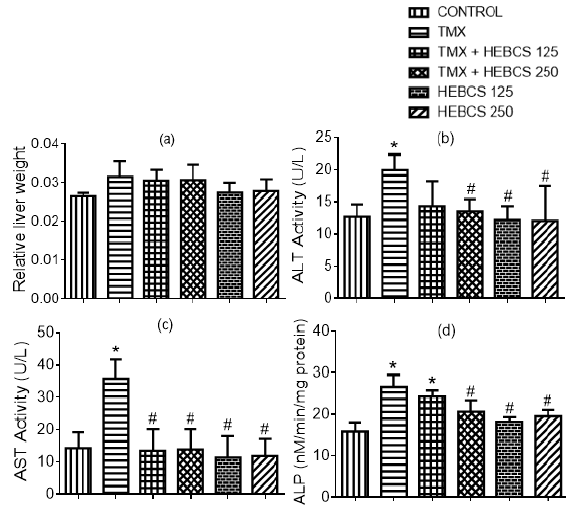
Figure 5. Effect of administration of TMX and HEBCS on ( a ) relative liver weight; ( b ) serum alanine aminotransferase (ALT) activity; ( c ) serum aspartate aminotransferase (AST) activity; ( d ) serum alkaline phosphatase (ALP) activity. Data are presented as mean ± SD ( n = 6). * p < 0.05 Control versus other groups; # p < 0.05 TMX versus HEBCS groups. TMX: Tamoxifen; HEBCS 125 and 250: Hydroethanolic Extract of Buchholzia coriacea Seeds, 125 and 250 mg/kg body weight.